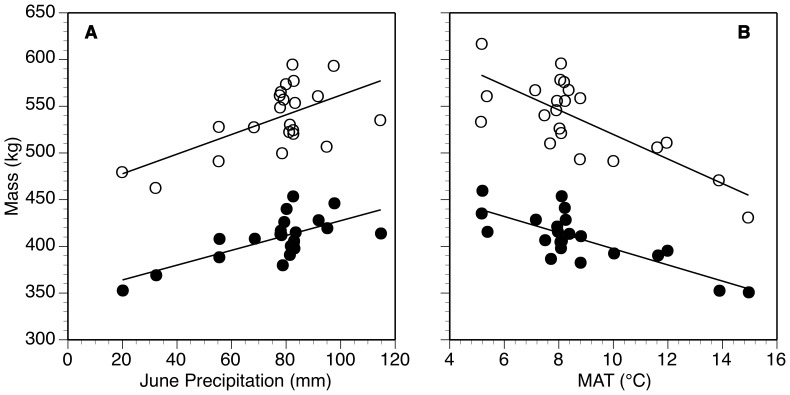
Patterns of body mass across climate gradients.Partial residual plots for standardized body mass and (a) mean June precipitation and (b) MAT across 22 herds. Separate lines for males (open circles) and females (solid circles).